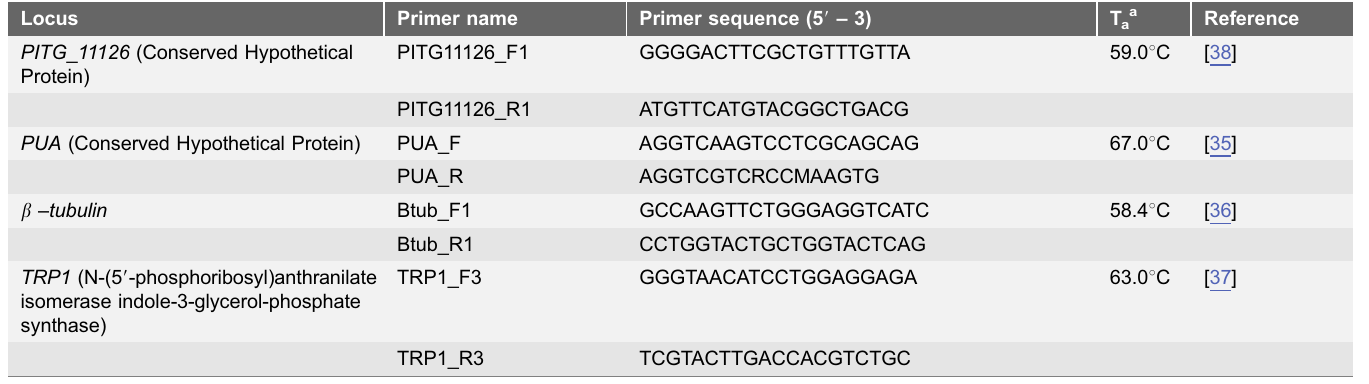
Table 1. Nuclear loci sequenced, primers, and amplification conditions used in this